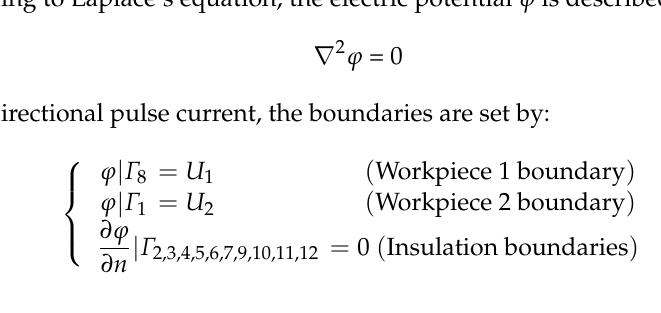
Figure 3. The waveform used in the simulation. Table 1. The parameters for the